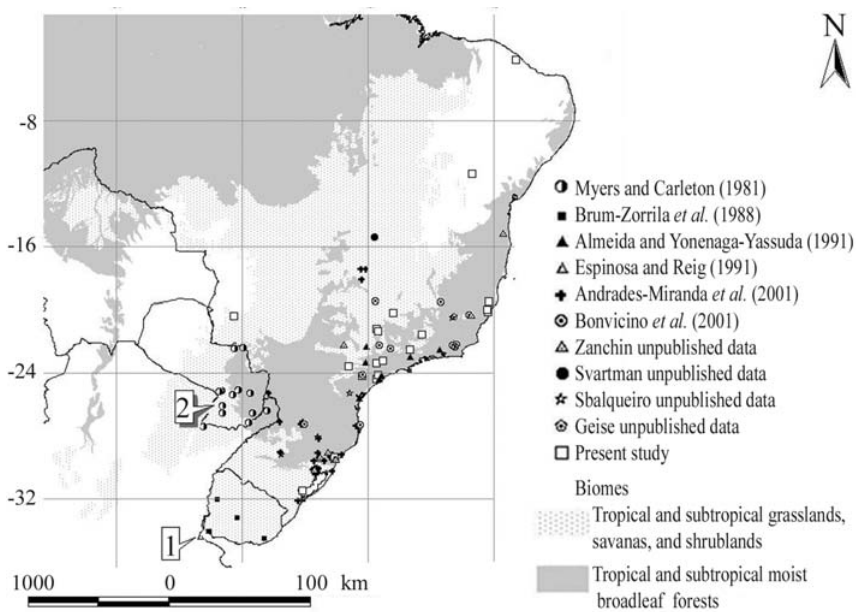
Figure 1 - Collection localities of Oligoryzomys nigripes (2n = 62/FN = 78-82). 1 and 2 represent the type localities for Oligoryzomys delticola and Oligoryzomys nigripes ,